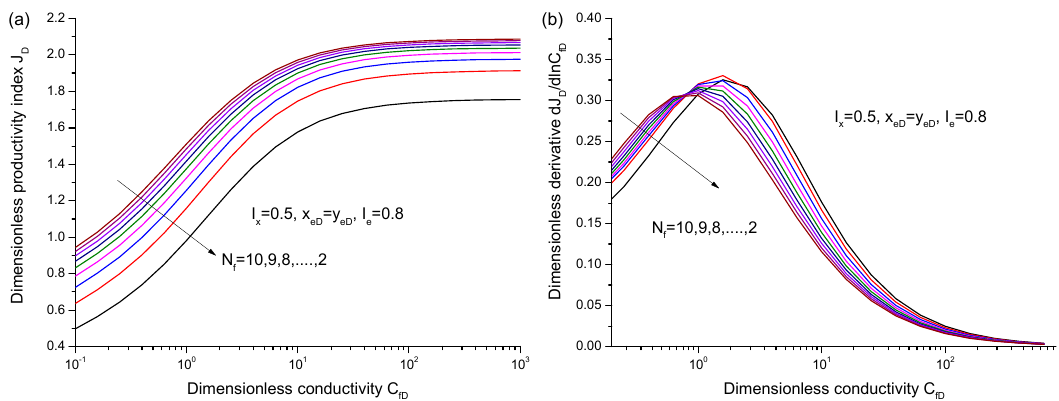
Figure 8. Influence of number of fractures on PI behavior, including ( a ) the productivity index vs. dimensionless conductivity, and ( b ) the derivative of productivity index vs. dimensionless conductivity.